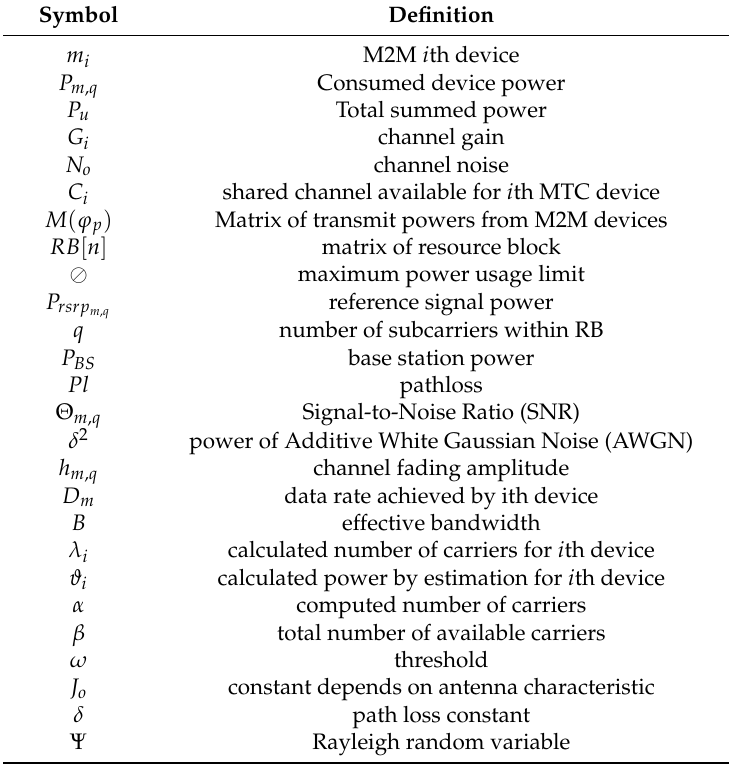
Table 2. Notations used in